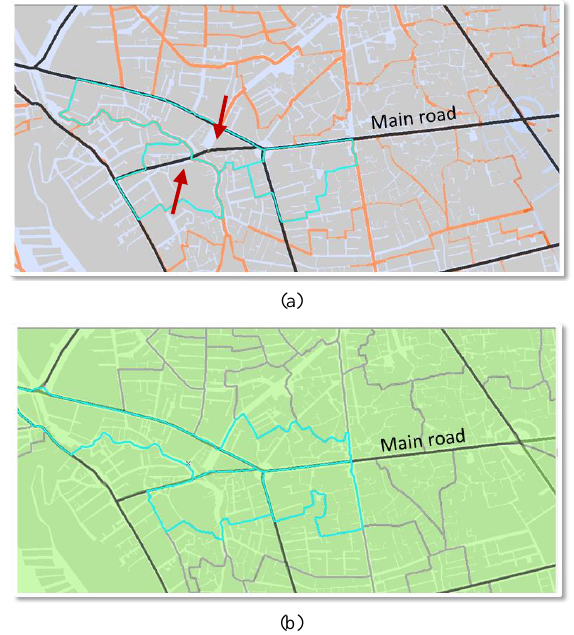
Figure 8. Comparison of the avoiding barriers for some districts produced by (a) the SCI and (b) the proposed approach. Note how the main road passes the districts produced by the SCI